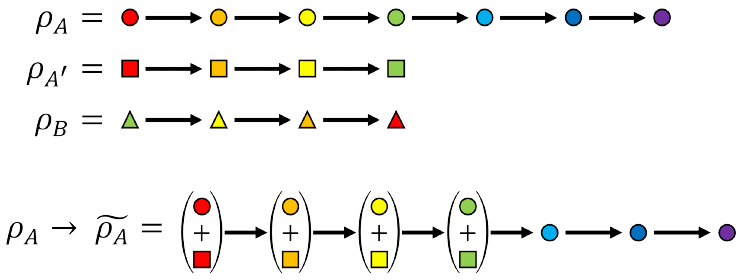
Figure 10: The representation ρ have the same structure as the leading parts A ′ = ρ dual of the representation ρ , and ρ . The basis change we consider here is A A ′ B ρ → ρ + c ρ A A A ′